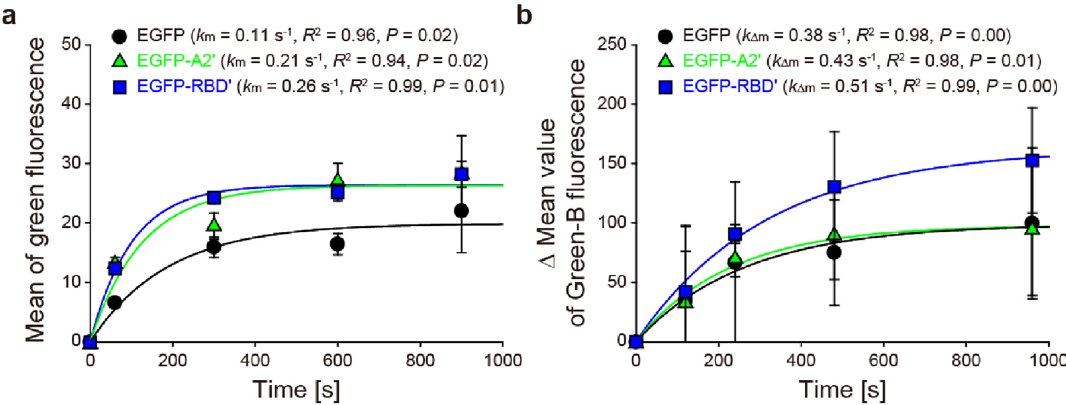
Figure 5. Characterization of adsorption/absorption of the recombinant peptides to differentiated PC-12 cells. ( a ) Mean of green fluorescence in the cells incubated with culture media containing the recombinant peptides (EGFP, EGFP-A2 ʹ , and EGFP-RBD ʹ ), determined using the ImageJ processing of confocal laser fluorescence microscopic images. ( b ) Changes in mean values for Green-B fluorescence signal of the cells incubated with the recombinant peptide-containing media, measured using the flow cytometry. All data represent average ± s.d. ( n = 3), the fitting curves were regressed with the equation [ f ( t ) = a (cid:31) 1 − b 0 < b < 1 ], and the adsorption/absorption rate constants (a, k m ; b, k (cid:31) m ) were determined from the equation as k m and k � m = f ′ ( 0 ) = − a ln b